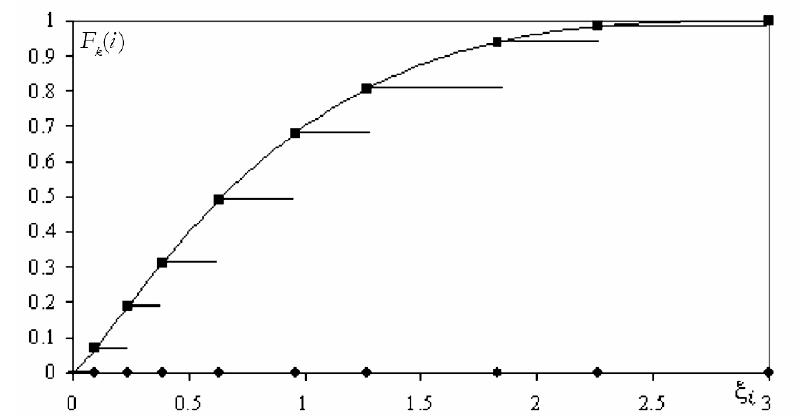
Figure 1 – Transforming the conventional scores i into values (cid:91) cumulative distribution function of the unitary element of the latent family of distributions, ref. (8) below for (cid:68) k (cid:32)